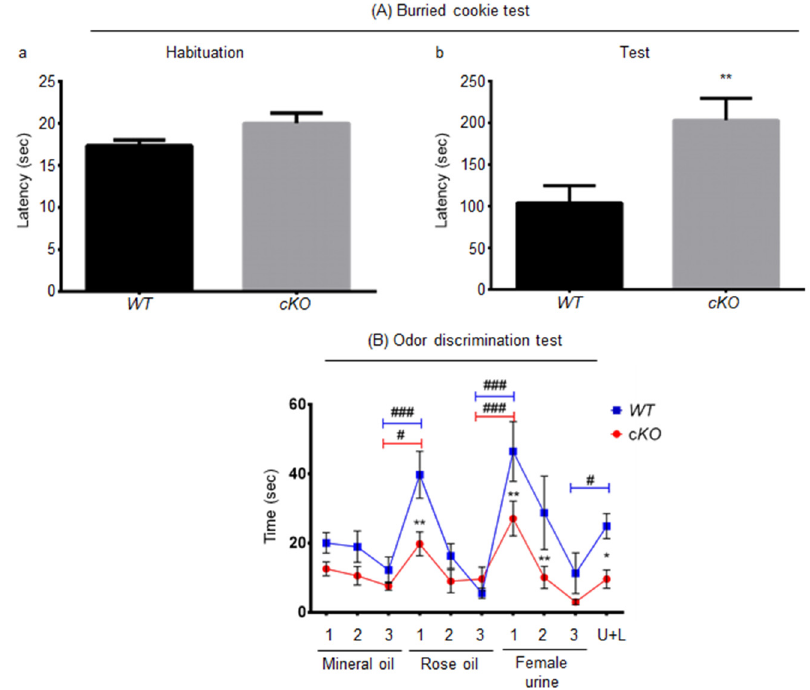
Figure 3. Olfactory assessment in cKO mice. ( A ) Buried cookie test results for WT ( n = 20) and cKO ( n = 18) mice. ( a ) Time taken to take and eat the visible cookie in habituation phase. ( b ) Time taken to find buried cookie. ( B ) Habituation/cross-habituation test results for WT ( n = 10) and cKO ( n = 10) mice. This test consists of a 5 min habituation step to the tea ball (no odor), then three 1 min habituation sessions to mineral oil, followed by three 2 min habituation sessions to rose oil, and by three 2 min habituation sessions to female urine. The test then ended with a 2 min odor discrimination step to female urine containing 1% lemon oil (U + L). Statistical significance when comparing a single point between cKO vs. WT mice is represented as: * P ≤ 0.05, ** P ≤ 0.01, *** P ≤ 0.001. Statistical significance when comparing different sessions for same genotype are indicated as: # P ≤ 0.05, ## P ≤ 0.01, ### P ≤ 0.001.